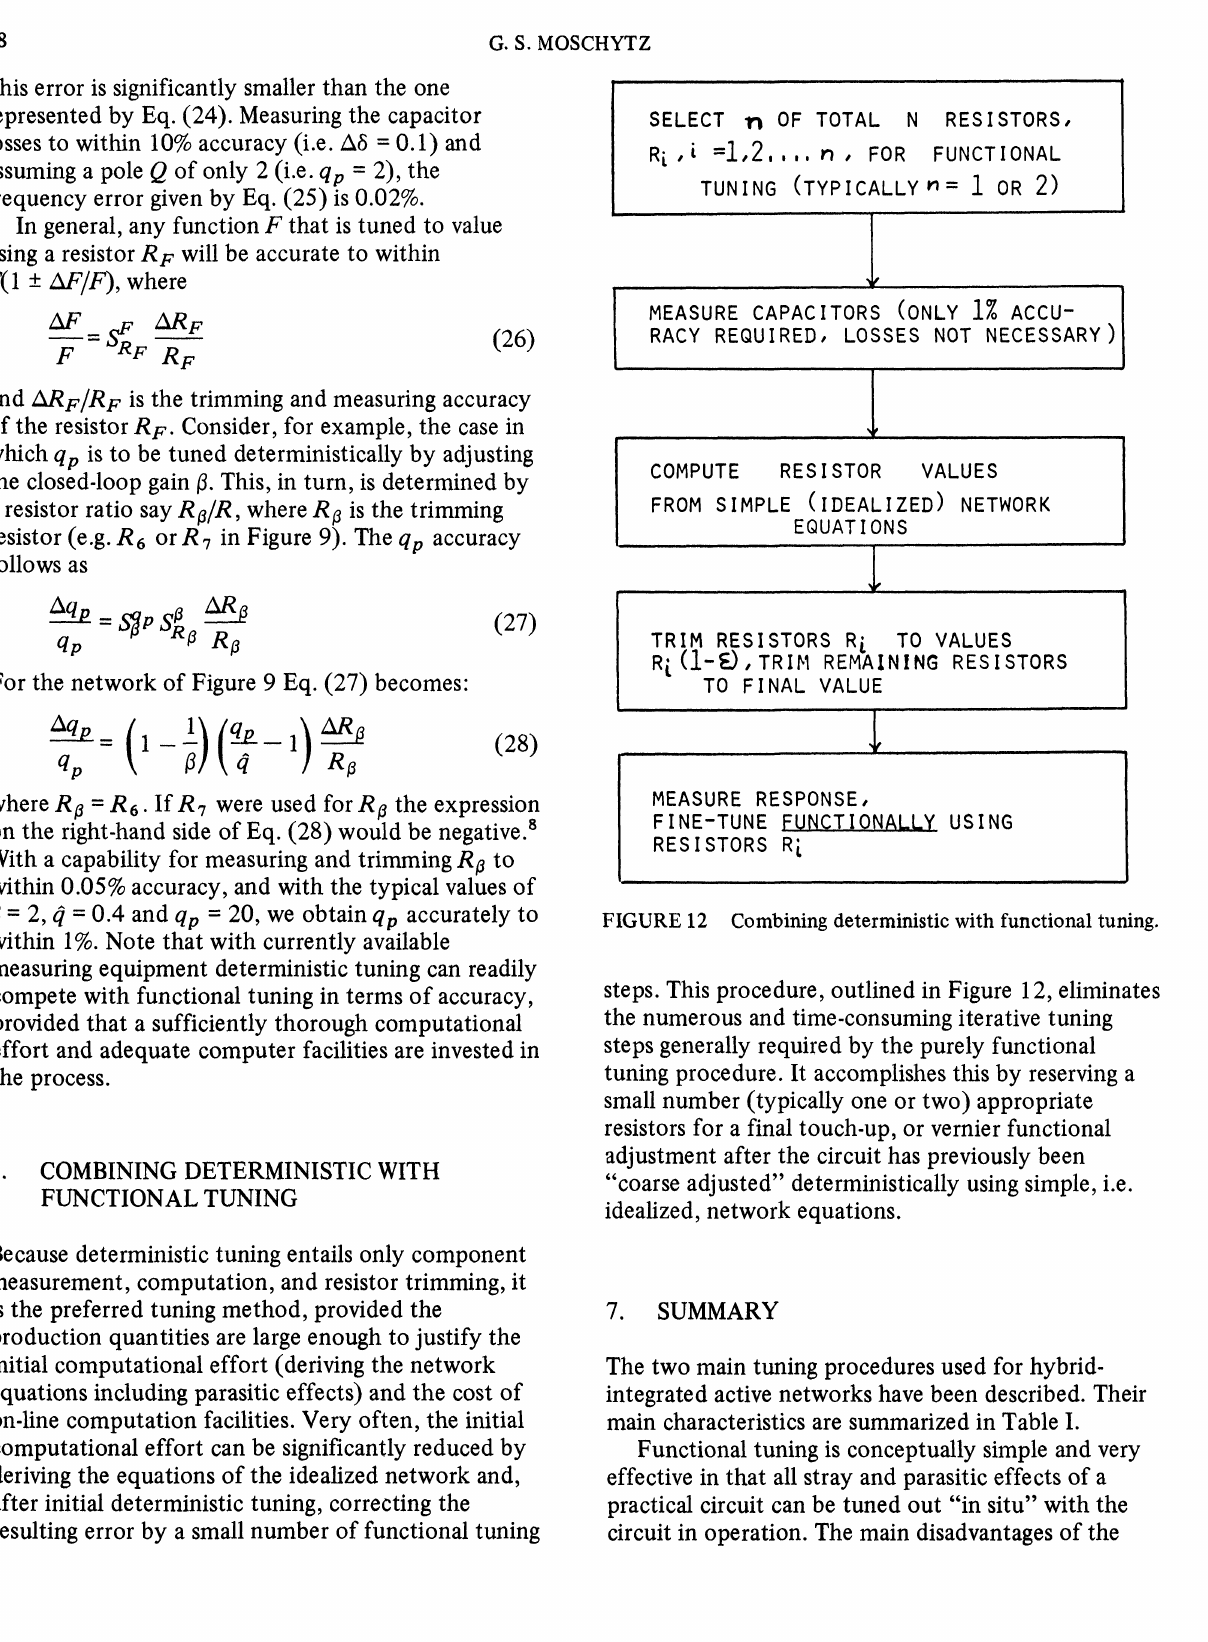
FIGURE 12 Combining deterministic with functional